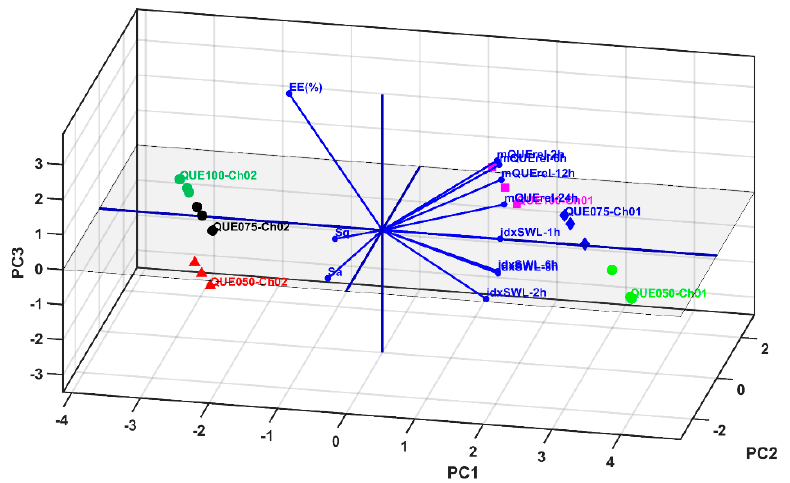
Figure 17. Biplot of PCA results in 3D representation for PC1, PC2 and PC3 principal components.